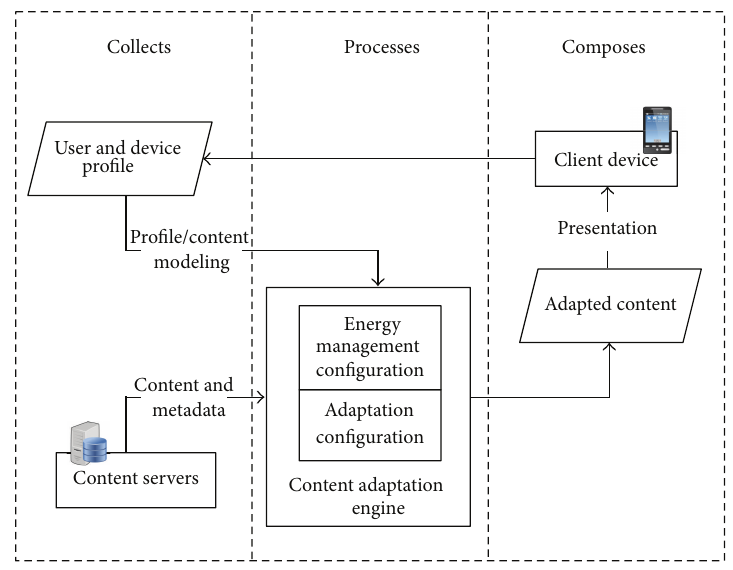
Figure 1: Energy-aware content adaptation